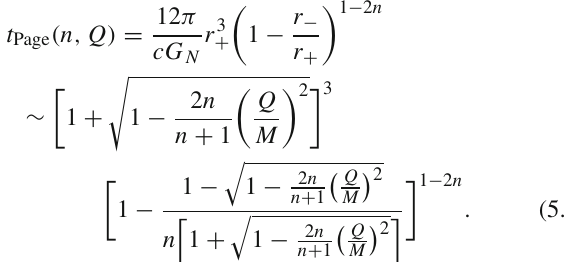
5 Page time and scrambling